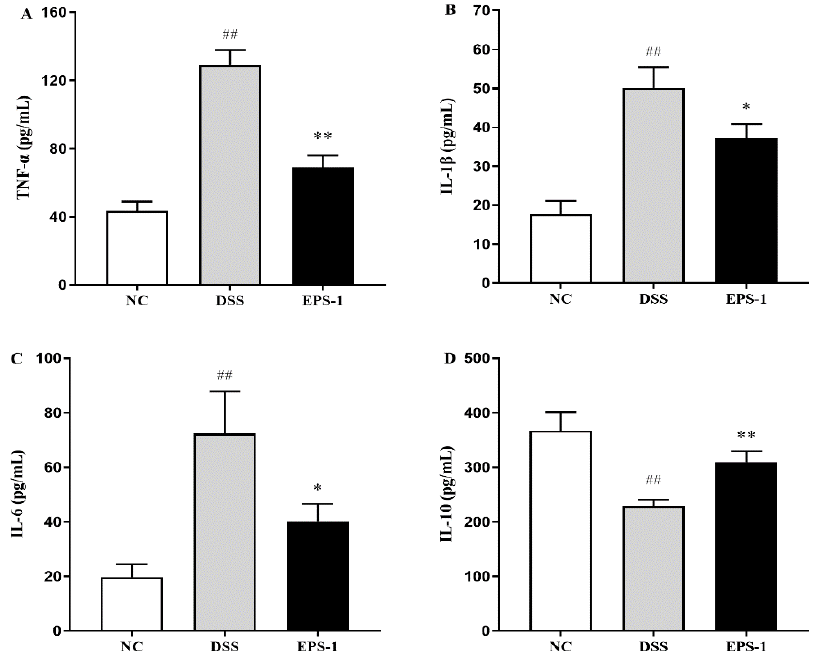
Figure 3. Effects of EPS-1 administration on inflammatory cytokines concentration. ( A ) TNF- α , ( B ) IL-1 β , ( C ) IL-6, and ( D ) IL-10. Data are presented as mean ± SD. ## p < 0.01 vs. the NC group, * p < 0.05 and ** p < 0.01 vs. the DSS model group by using one-way analysis of variance, followed by Duncan’s